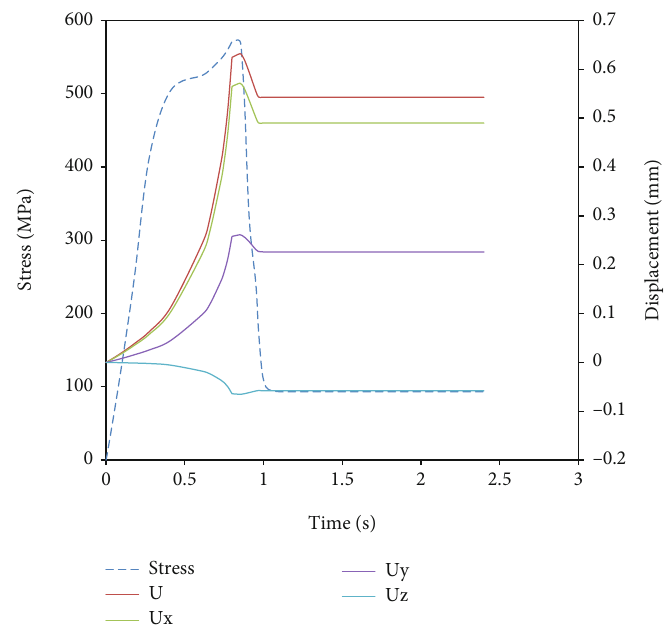
Figure 14: Variation of displacement and stress with